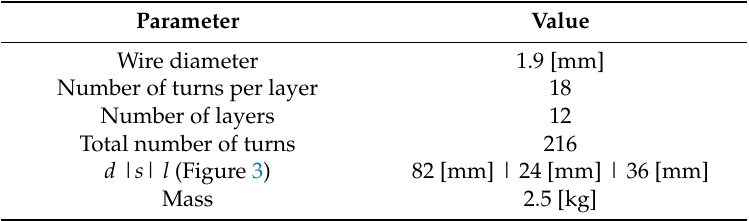
Table 2. Important design and construction